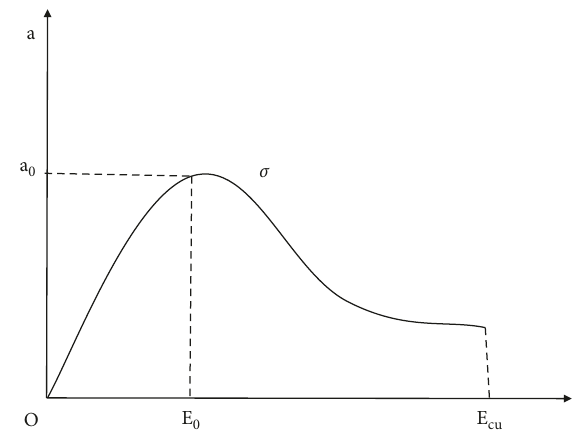
Figure 2: Stress-strain relationship of concrete under uniaxial compression.